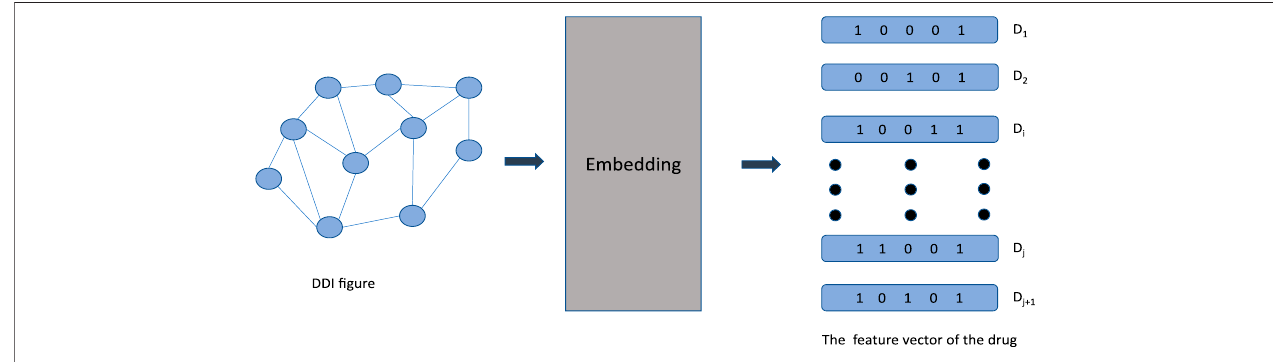
FIGURE2| StartbycreatingthegraphstructureoftheDDI.D 1 throughD j+1 indicatesthedrugnumber.Nodesrepresentdrugsandedgesrepresentrelationships between drugs. The high dimensional graph structure is transformed into low dimensional vector by embedding